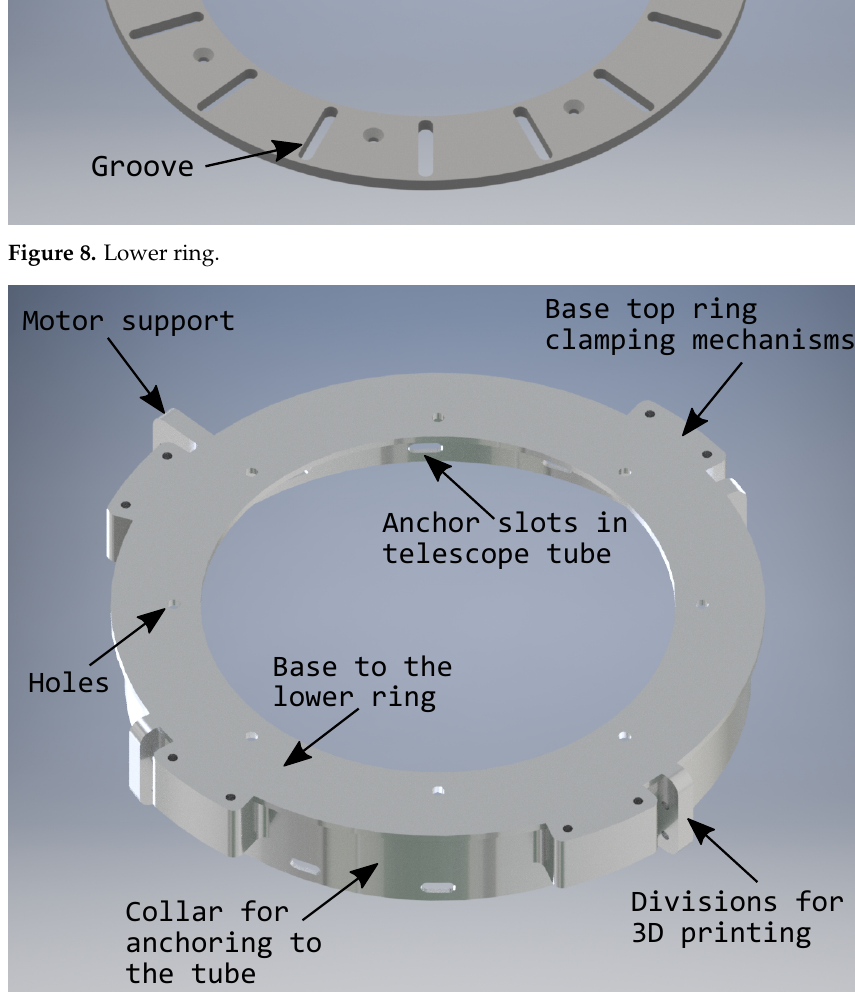
Figure 9. Support